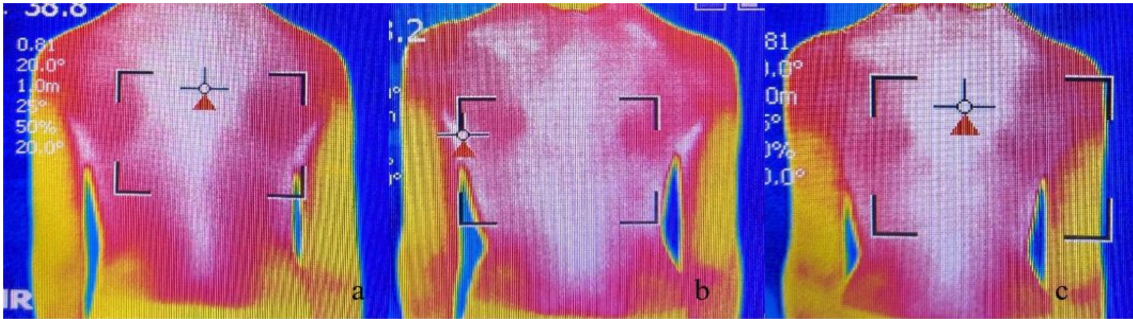
Figure 8. Subject with scoliosis 1 ( a ) image taken at the beginning of the experiment 1; ( b ) image taken at the end of the experiment 1; ( c ) image taken at the end of the experiment 2.